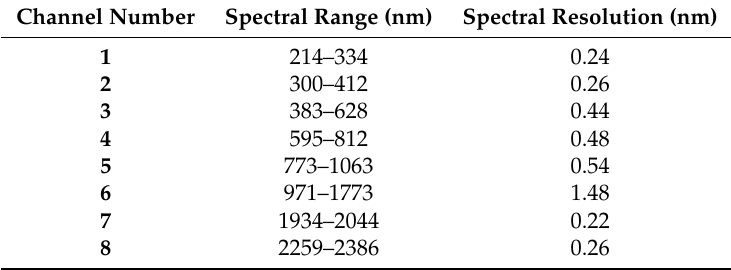
Table 1. The SCIAMACHY instrument channels. The spectral resolution in column 3 is also the FWHM (Full width at half maximum) of the corresponding ISRF Instrument Spectral Response Function).